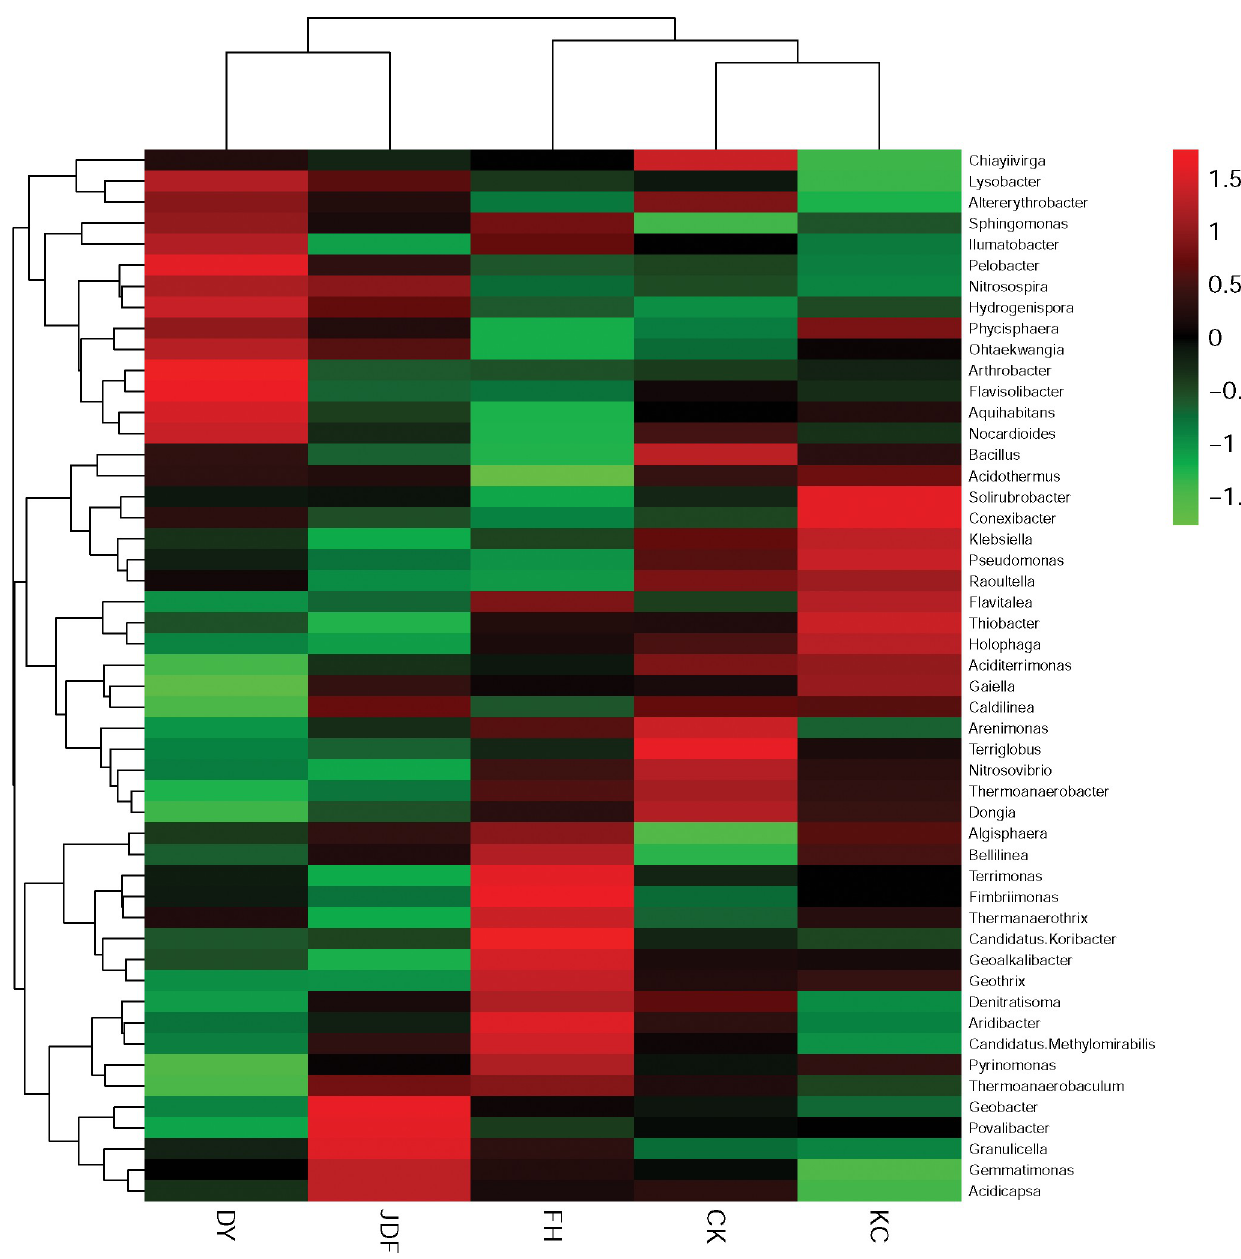
Fig 3. Heat map with a phylogenetic tree generated at the genus level. CK, KC, DY, JDF, and FH groups indicate control, B . subtilis , B . licheniformis , B . amyloliquefacien s, and combined strains treatments,